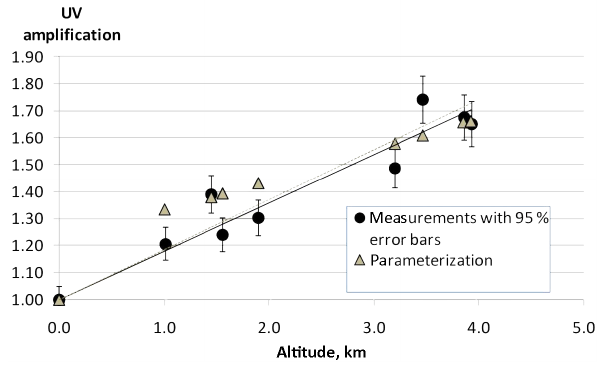
Figure 7. The comparison between the total altitude UV ampli- fication according to the proposed method and the A UV values evaluated using the accurate RT model (TUV, 8-stream DISORT method). See the details in the text.